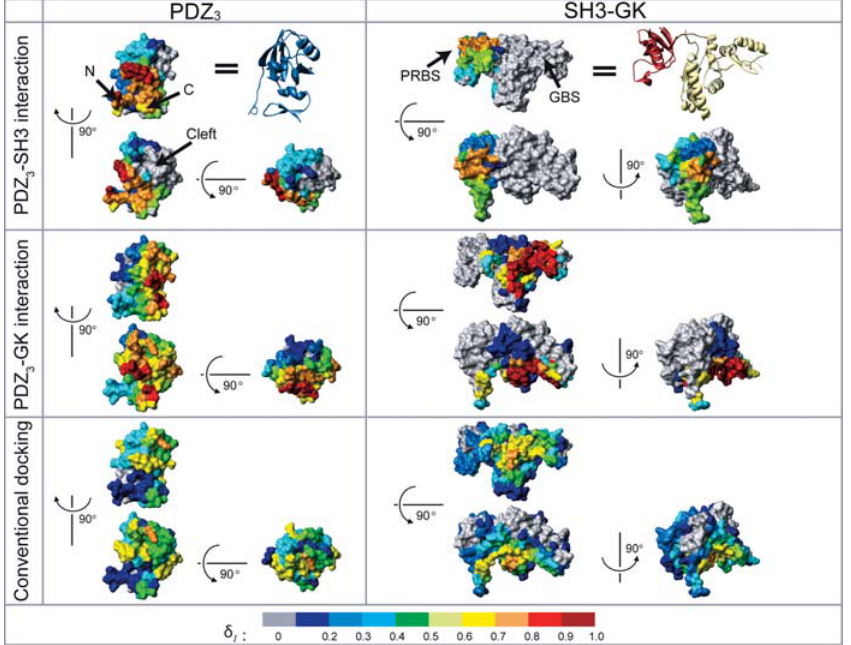
Figure 4. The Localization of Binding Sites for Both Modeled Configurations of the PDZ 3 –SH3–GK Core Fragment Compared with Protein Docking Top ten scoring models were selected for both interactions (PDZ 3 –SH3, PDZ 3 –GK) obtained using comparative patch analysis and using conventional protein docking. The localization index d I of a residue defines the relative frequency of its participation in the interaction interface. The residues that are colored grey do not participate in the interface of any of the top ten models. The PRBS in SH3 and the GBS in GK are shown by arrows.